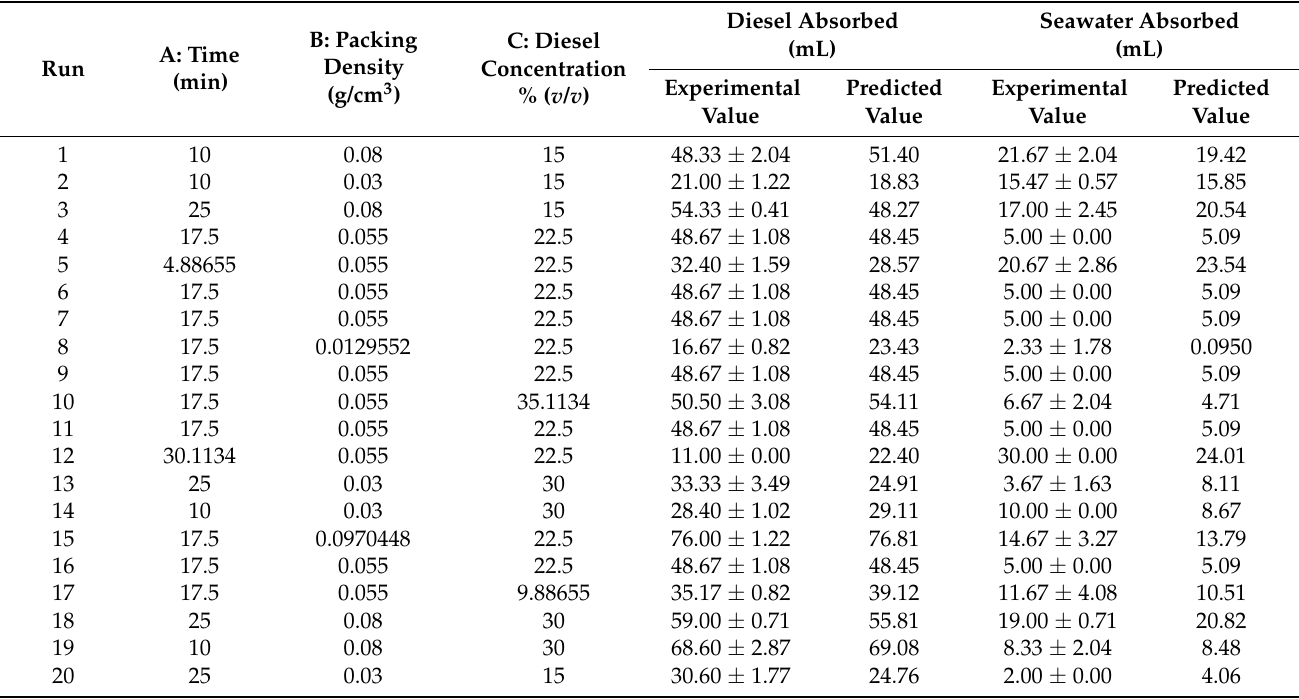
Table 3. Optimisation of factors affecting diesel–seawater sorption by CP using central composite design (CCD) ( ± SEM, n = 3).